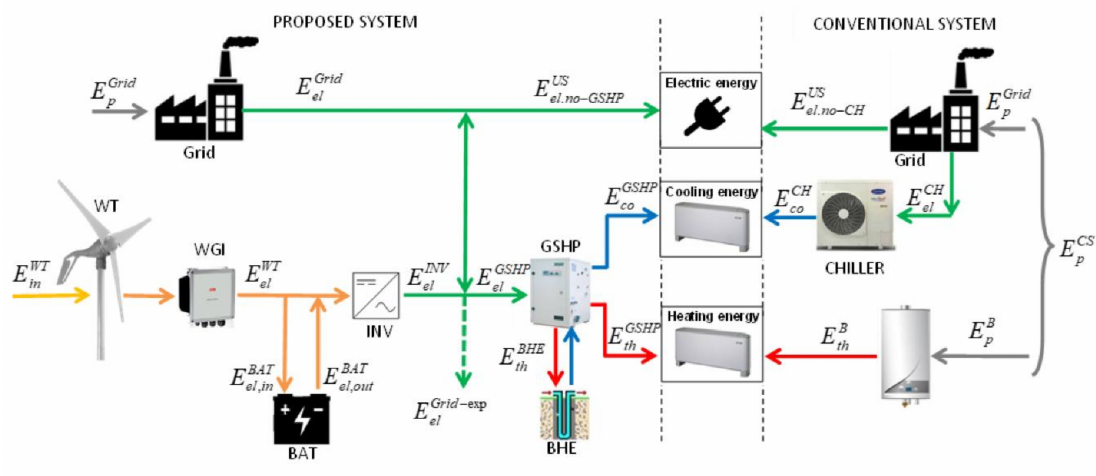
Figure 5. Proposed and conventional systems in heating and cooling configurations. Reproduced from [156], Energies,